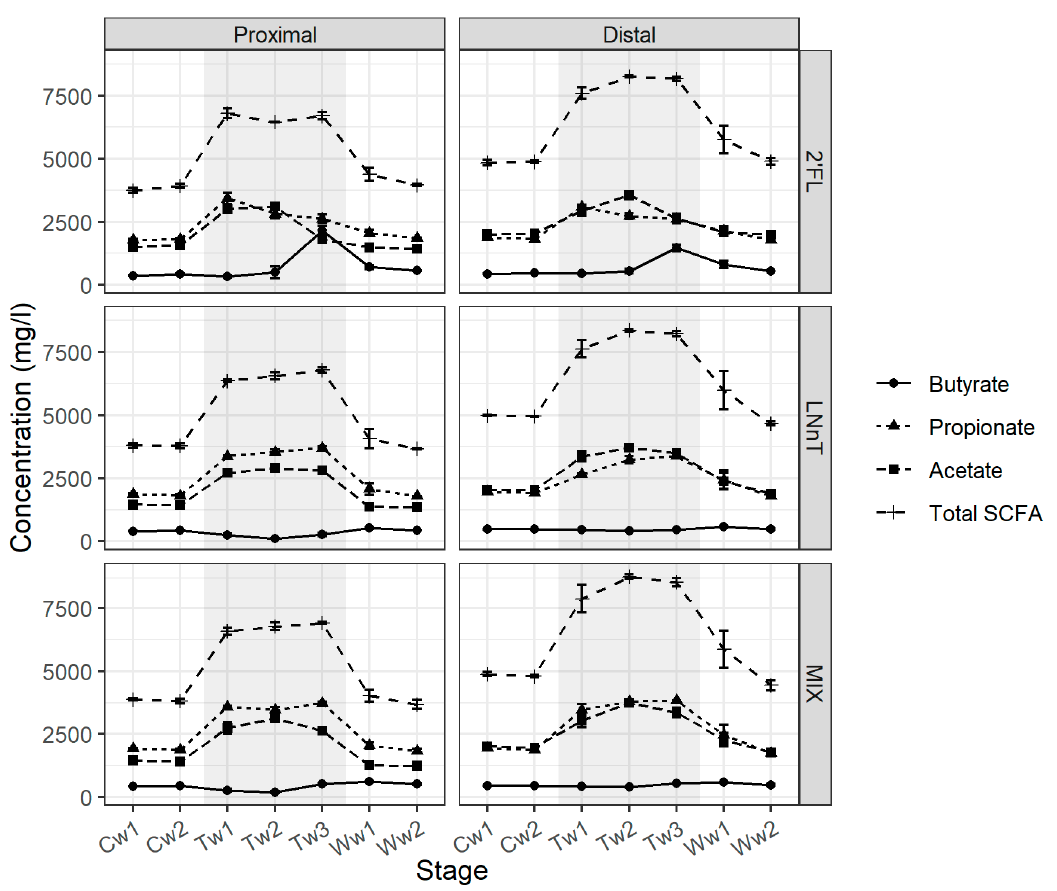
Figure 1. Impact of human milk oligosaccharides (HMOs) on short chain fatty acid (SCFA) production using the Simulator of the Human Intestinal Microbial Ecosystem (SHIME ® ) model. Absolute values of acetic acid, propionic acid, butyric acid, and total SCFA associated with 2’FL ( top panel ), LNnT ( middle panel ), and MIX ( bottom panel ) in the proximal and distal colon reactors are presented. Samples for SCFA analysis were collected during two weeks of control period (Cw1 and Cw2), three weeks of treatment period (Tw1, Tw2, and Tw3), and two weeks of washout period (Ww1 and Ww2). Three samples were collected each week. Error bars correspond to standard errors calculated from the 3 measurements per relevant week.